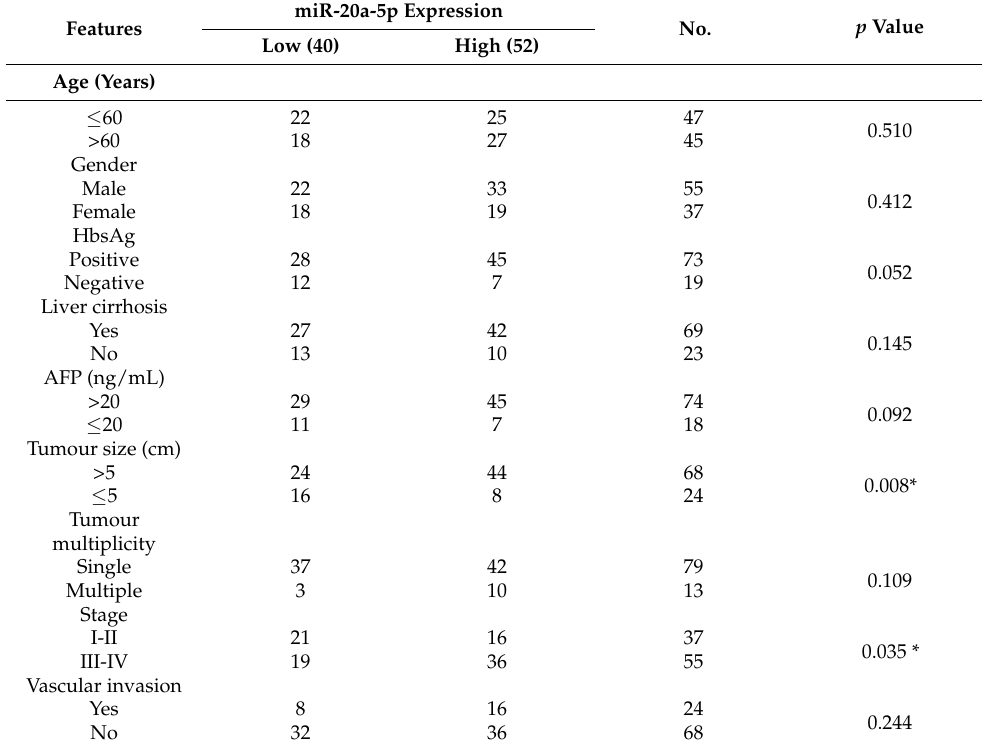
Table 3. The clinicopathological characteristics analysis of miR-20a-5p expression in HCC patients.